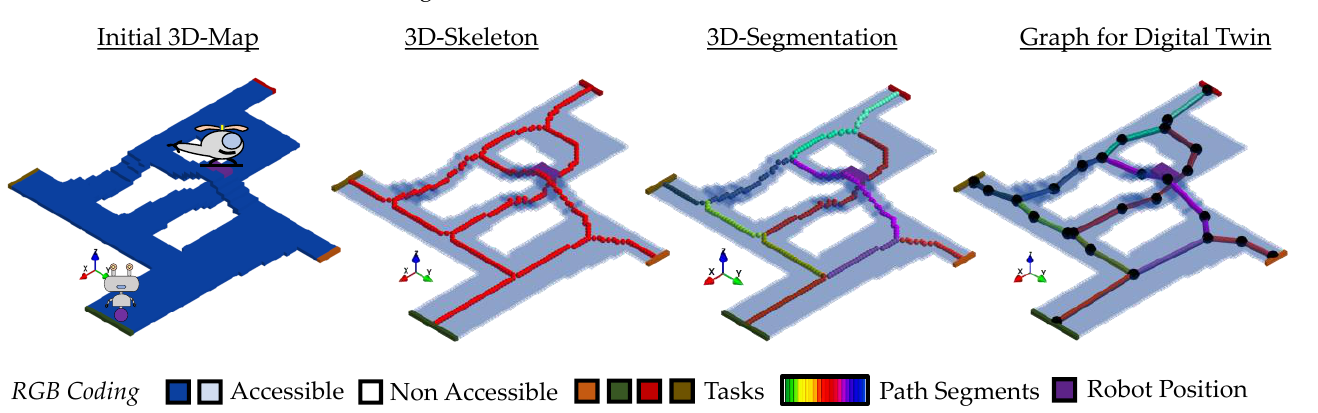
Figure 22. Generation of graphs for 3D maps: 3D RGB map, the skeleton of the 3D map, the